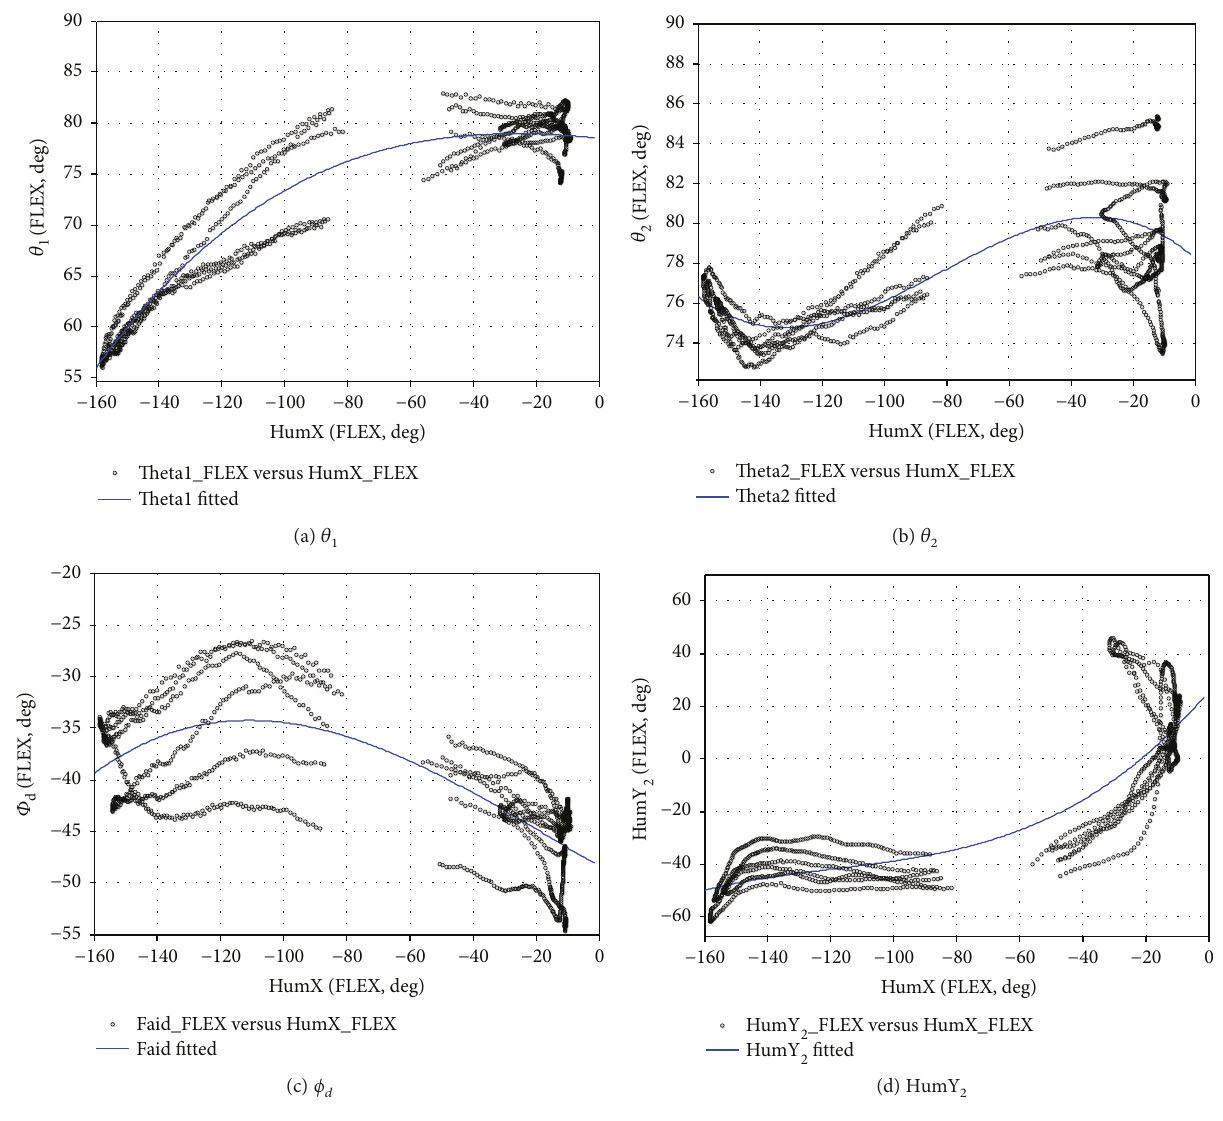
Figure 21: The joint angles are fi t using a third-order polynomial (FLEX). Table 7: Third-order polynomial fi t parameters of the rhythm function